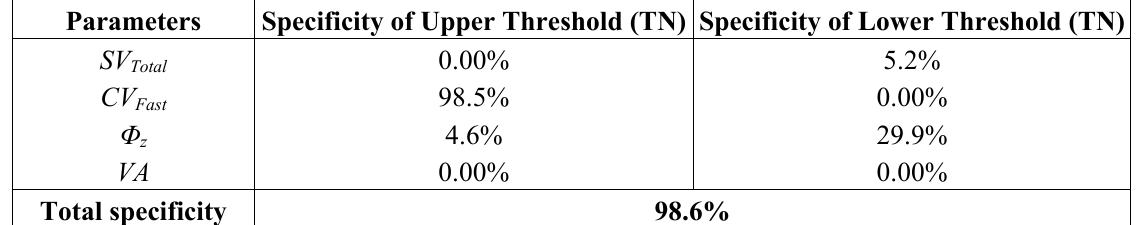
Table 11. The testing results of the threshold-based method for only four falling